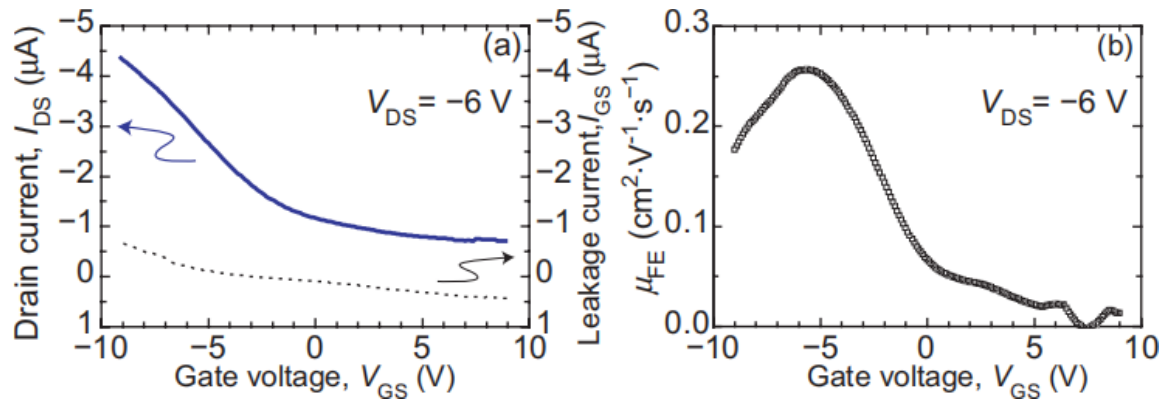
Figure 4: Characteristics of the first p-type Cu 2 O TFT [40]